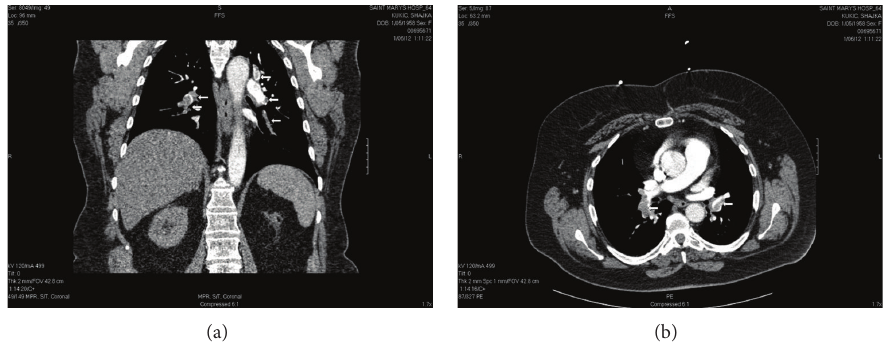
Figure 1: CT scan of chest, coronal view. White arrows point to bilateral pulmonary emboli.